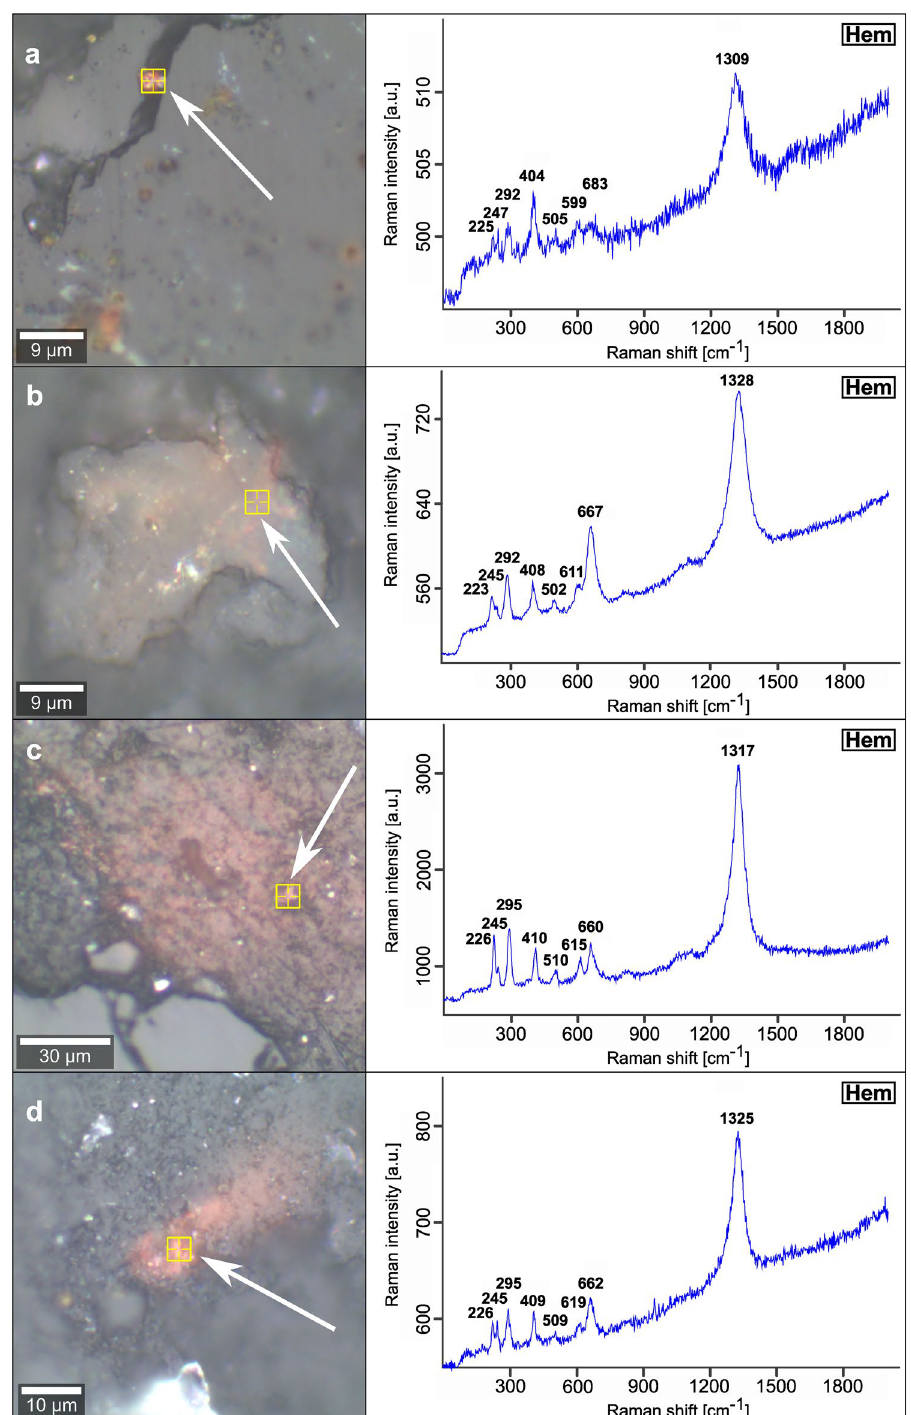
Figure 4. Raman spectra of hematite deduced from micrometer-scale crystals embedded in soil aggregates. (a–d) Reflected light microphotographs in combination with Raman spectra of hematite. Bold numbers represent the wavenumbers of diagnostic Raman bands. Yellow markings indicate the localizations of the respective measurements. Hematite precipitates have been either observed in small voids of silicate components (MB 2 glass, ( a ) or form more extended Fe-(hydr)oxide crusts within the aggregates ( b–d